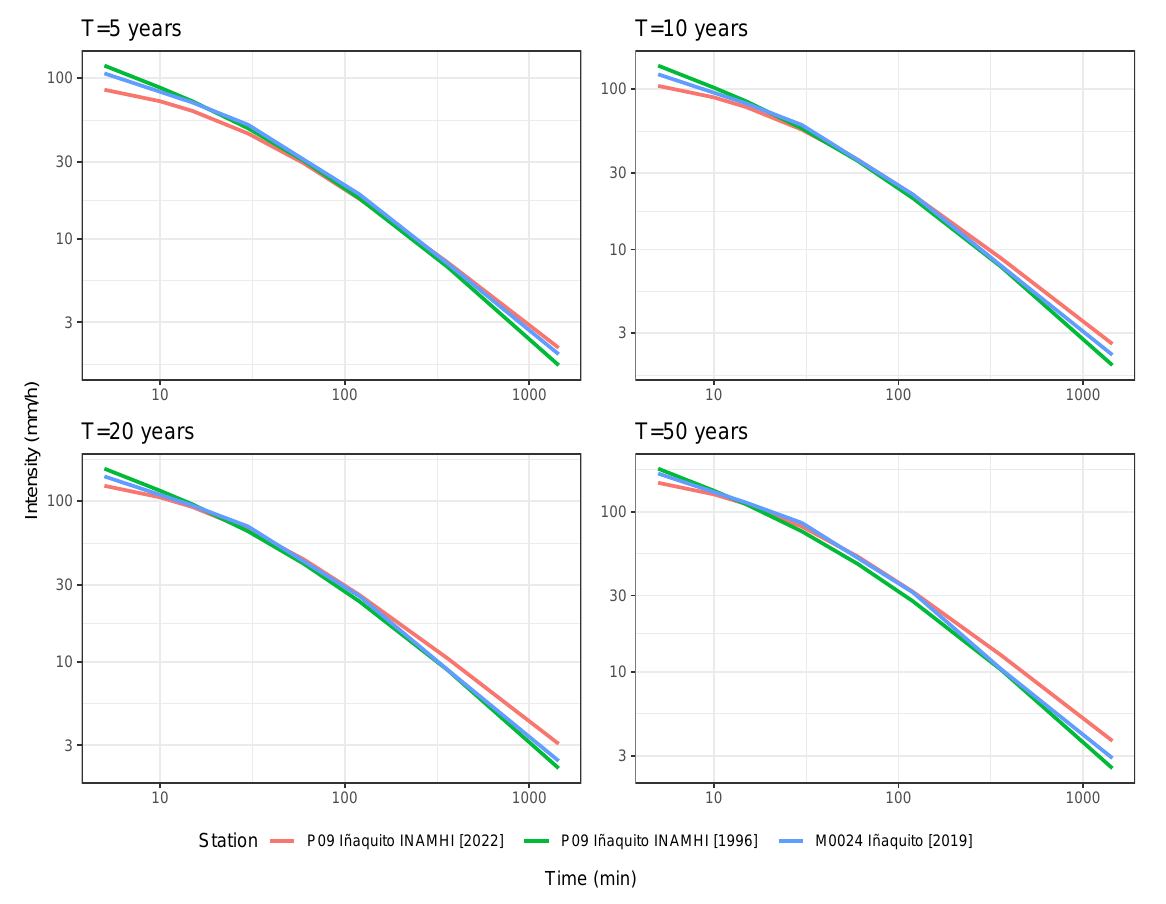
Figure 11. Comparisson of IDF curves, Iñaquito INAMHI.